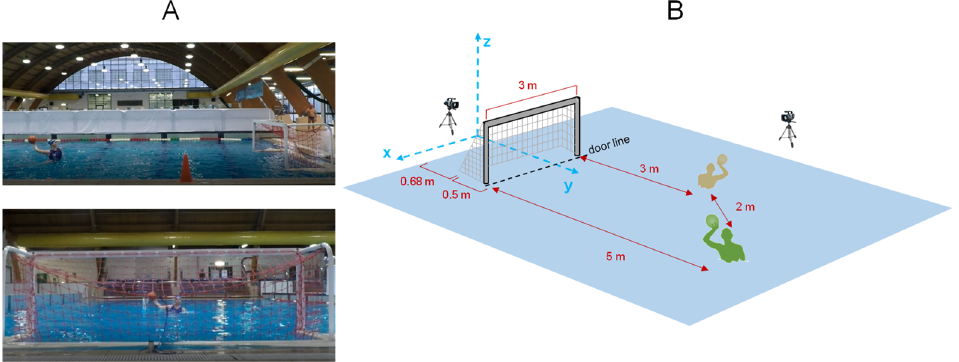
Figure 1. Example of one player performing the shot ( A ); 3D scheme of capture volume during the experiments ( B ). The yellow icon represents the second player in case of ball passage while the green icon represents the player performing the shot.